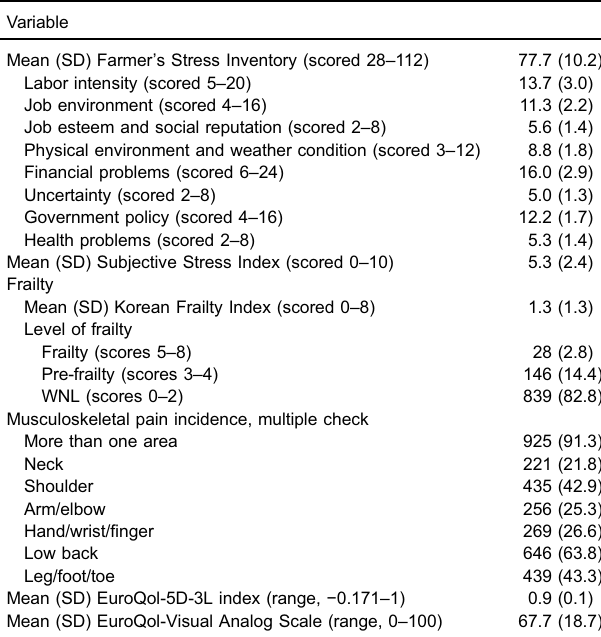
Table 4. Health characteristics of enrolled subjects ( n = 1013) Variable Mean (SD) Farmer ’ s Stress Inventory (scored 28 – 112)